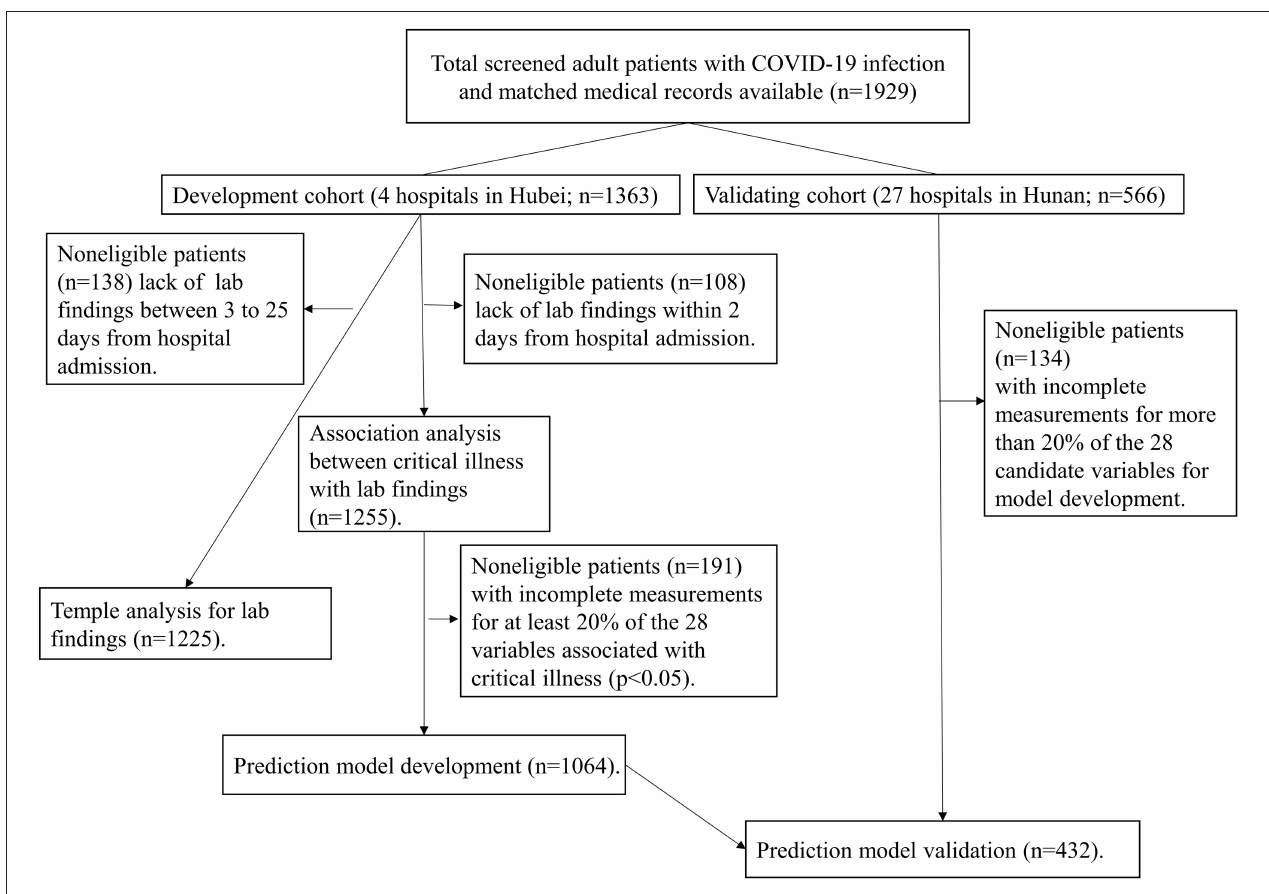
FIGURE 1 | Study flowchart detailing which samples were utilized at each phase of statistical analysis. COVID-19: severe coronavirus disease 2019.